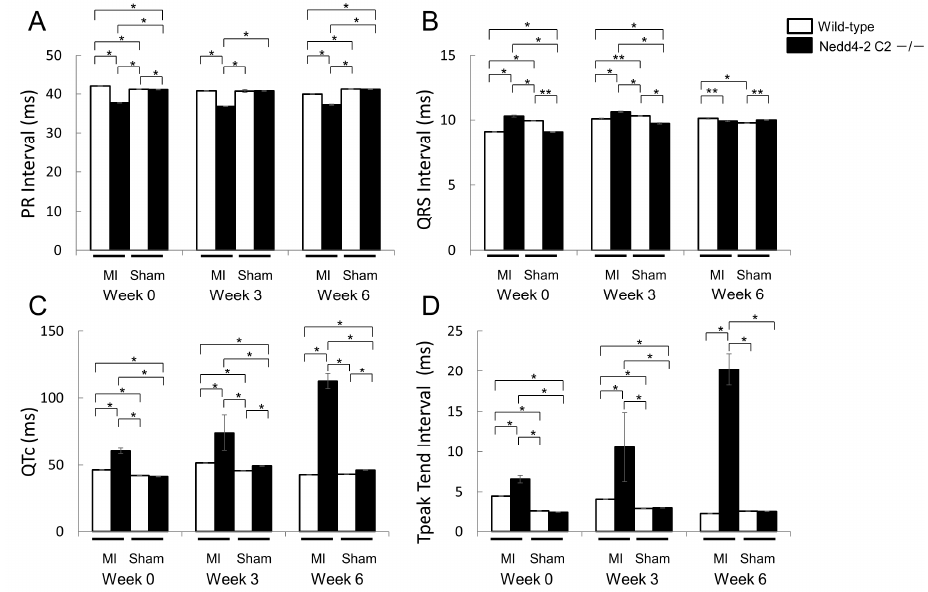
Figure 5. Comparison of electrocardiographic findings between wild-type and Nedd4-2 C2-knockout mice after myocardial infarction. Male wild-type littermates ( n = 4; 11–14 weeks old) and Nedd4-2 C2 − / − mice ( n = 4; 11–14 weeks old) were used for this experiment. A for PR intervals, B for QRS intervals, C for QTc intervals, and D for T peak T end intervals, respectively. Data are expressed as means ± SE. Nedd4-2 C2-knockout mice showed enhancement of T peak/T end interval with surgical ligation of the distal left coronary artery. MI; myocardial infarction. * p < 0.0001, ** p < 0.001.